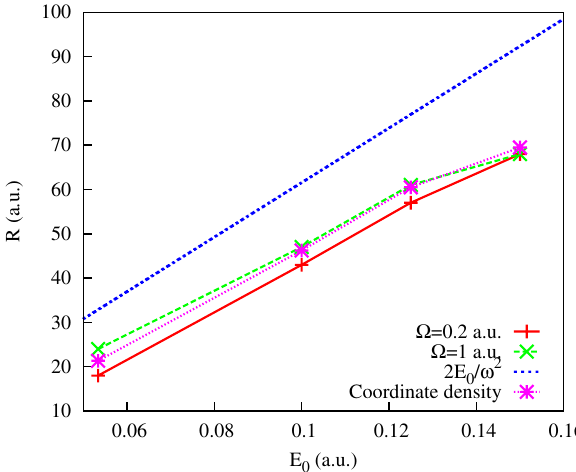
Figure 10. ‘Internuclear’ distances obtained from the interference patterns in Figs. 3 and